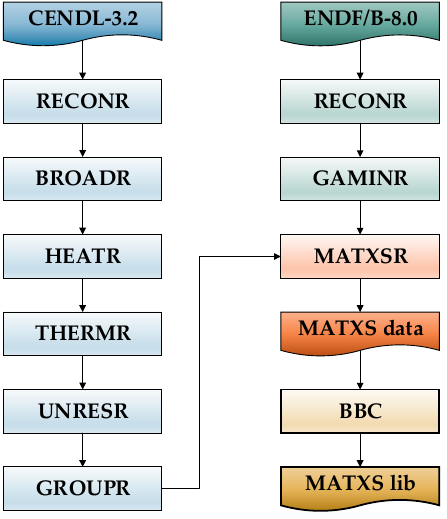
Figure 3. Processing flow of MATXS-format multi-group cross section library.